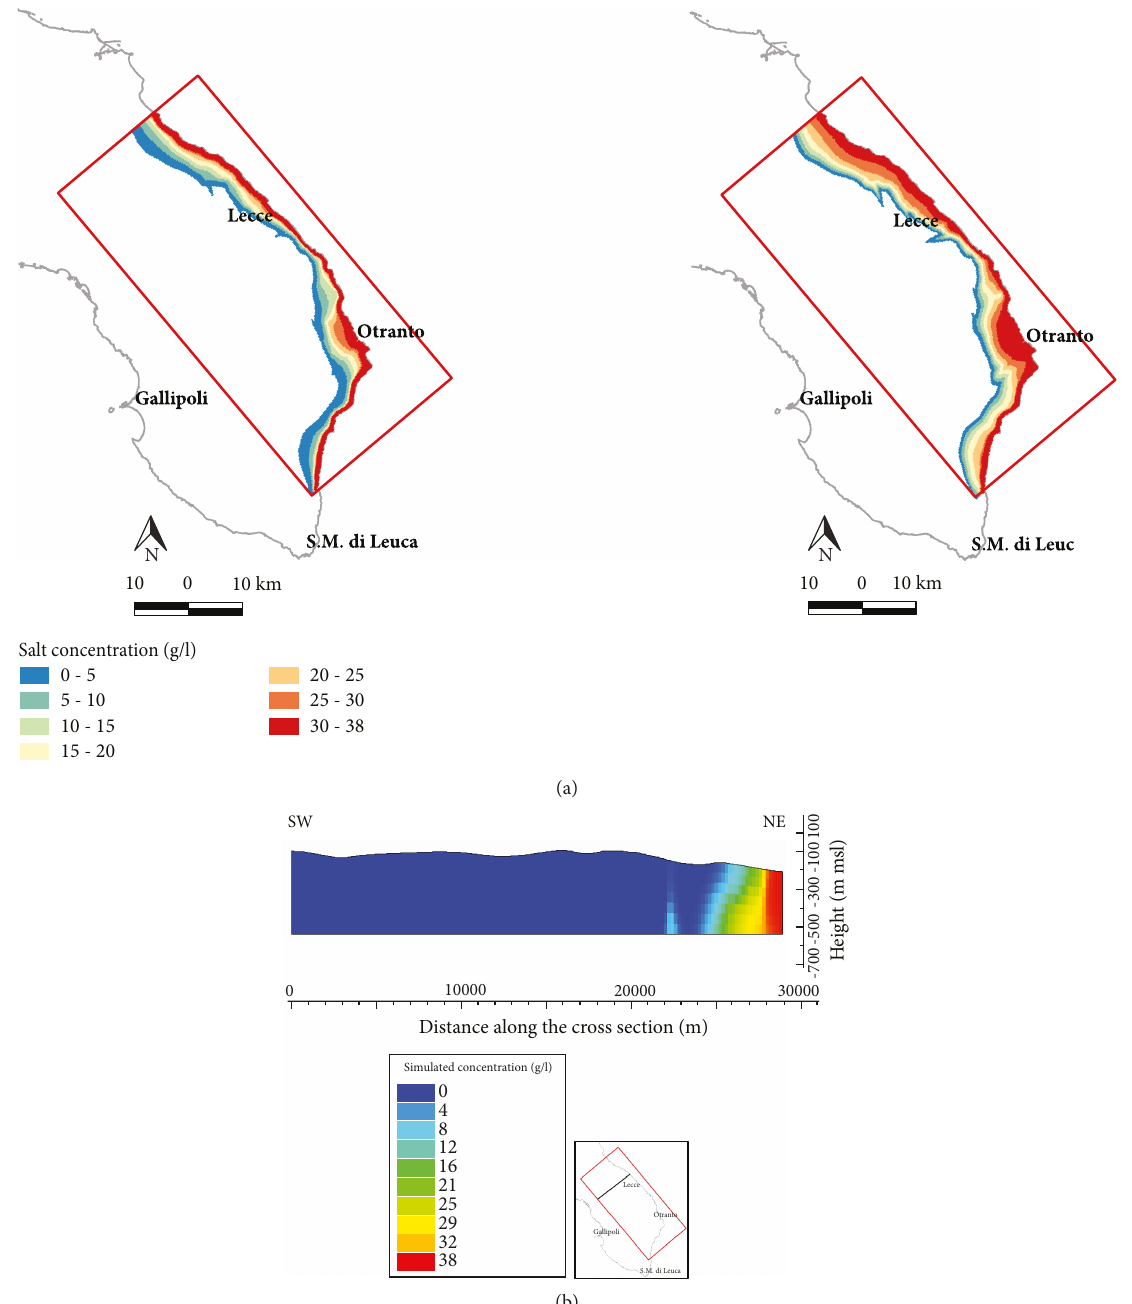
Figure 9: (a) Lateral saltwater intrusion simulated for sublayer 1 (left side) and for sublayer 7 (right side). (b) Vertical cross section along a SW-NE pro fi le near